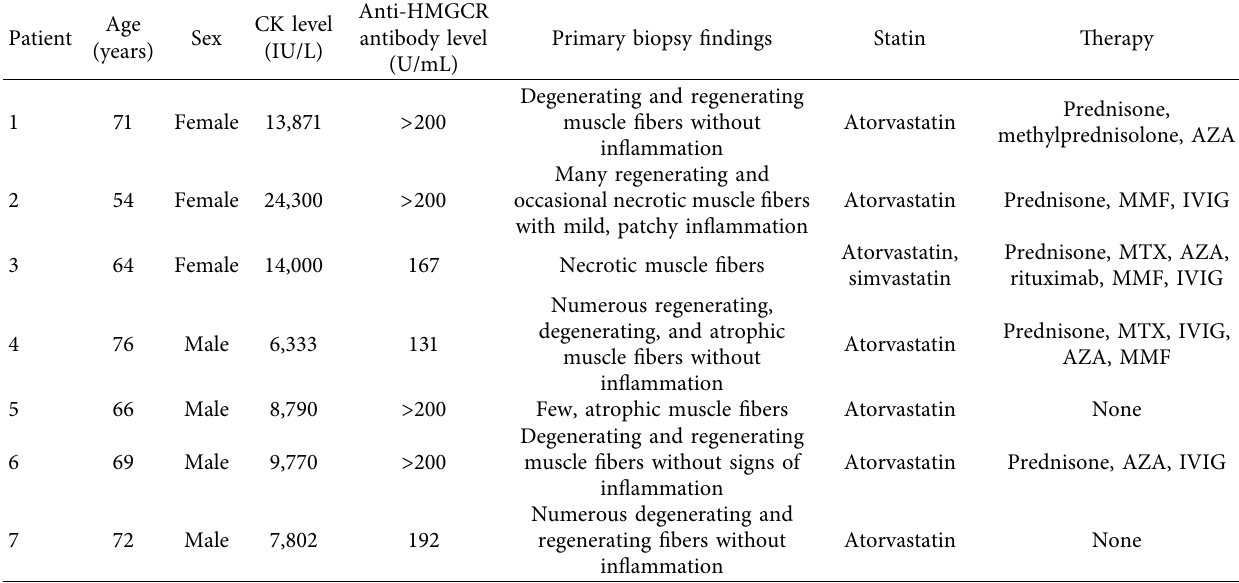
Table 1: Summary of